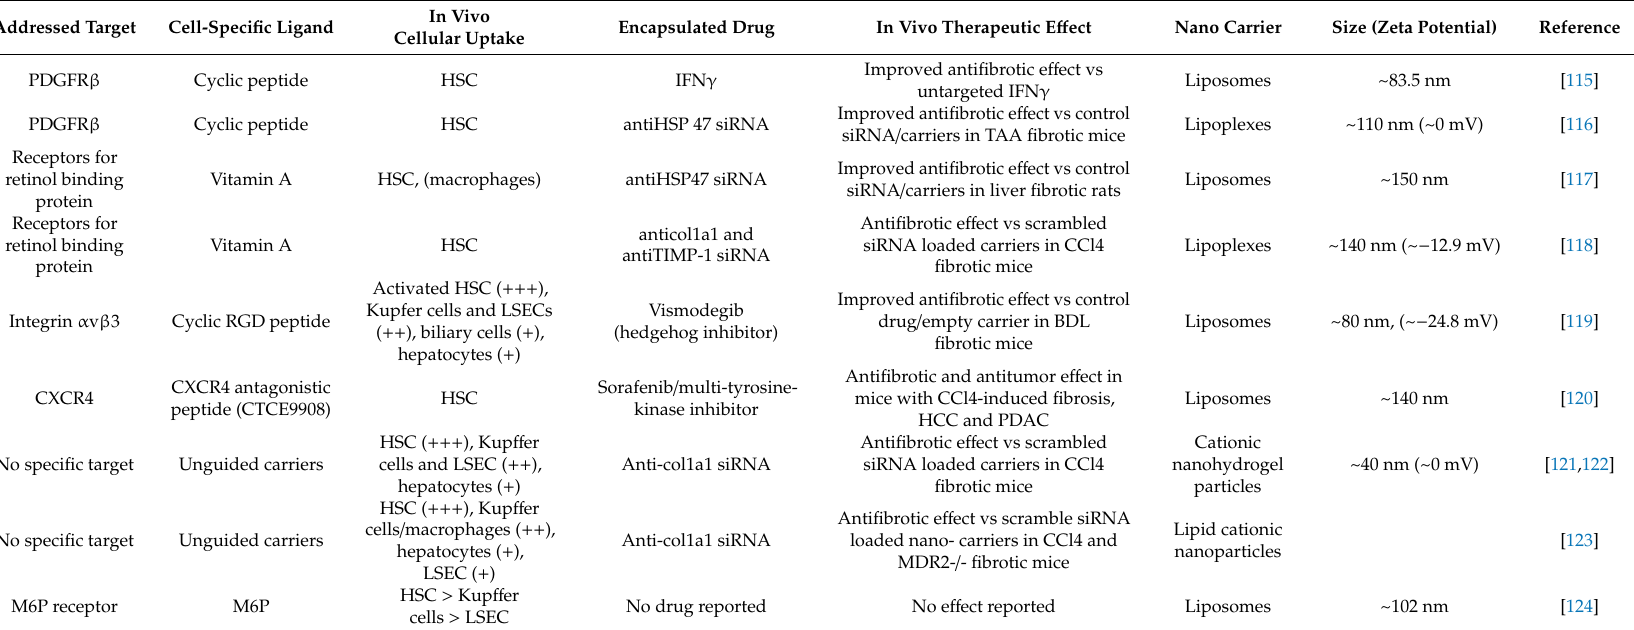
Table 2. Nanocarriers for cell-specific drug delivery to